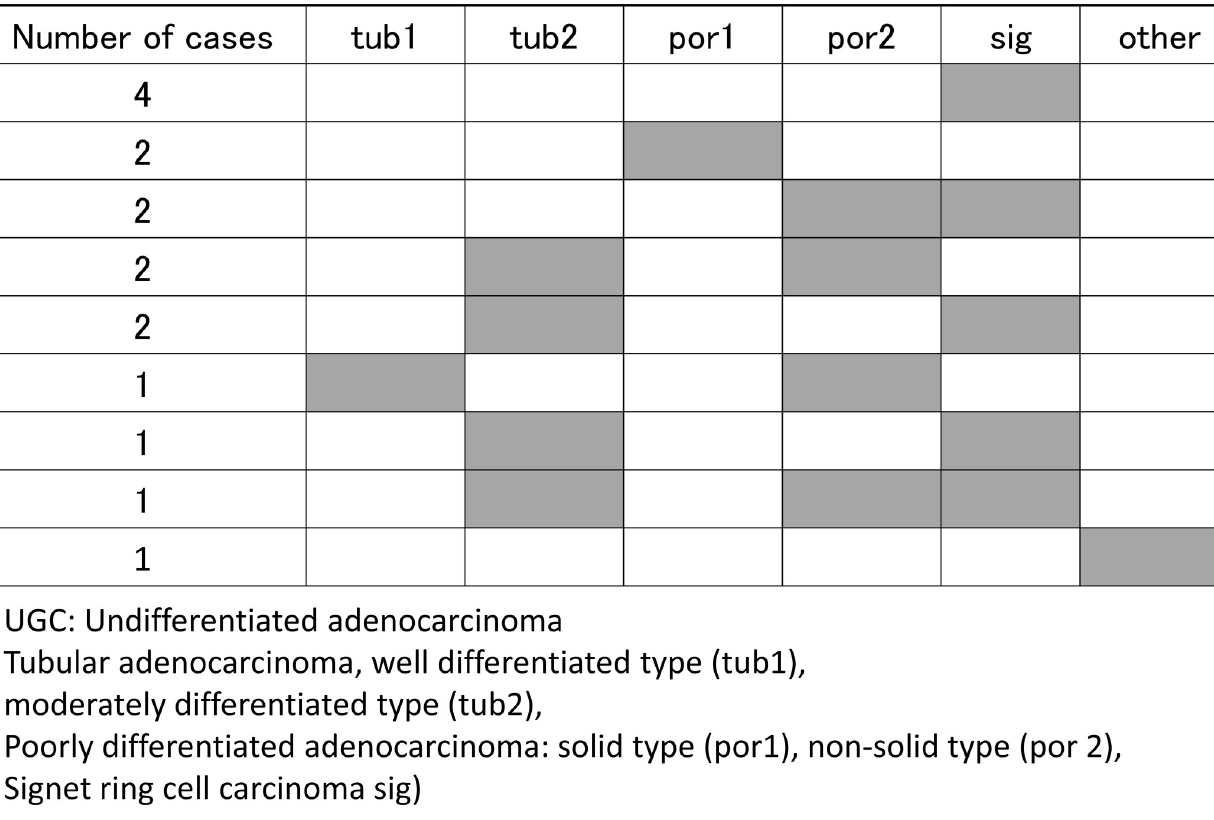
Fig 2. Distribution of intra-tumor histologic types of the UGC group. Several tumors featured different gastric cancer histologic types according to the Japanese Classification of Gastric Carcinoma (English version is 3rd 2011, October 2017).